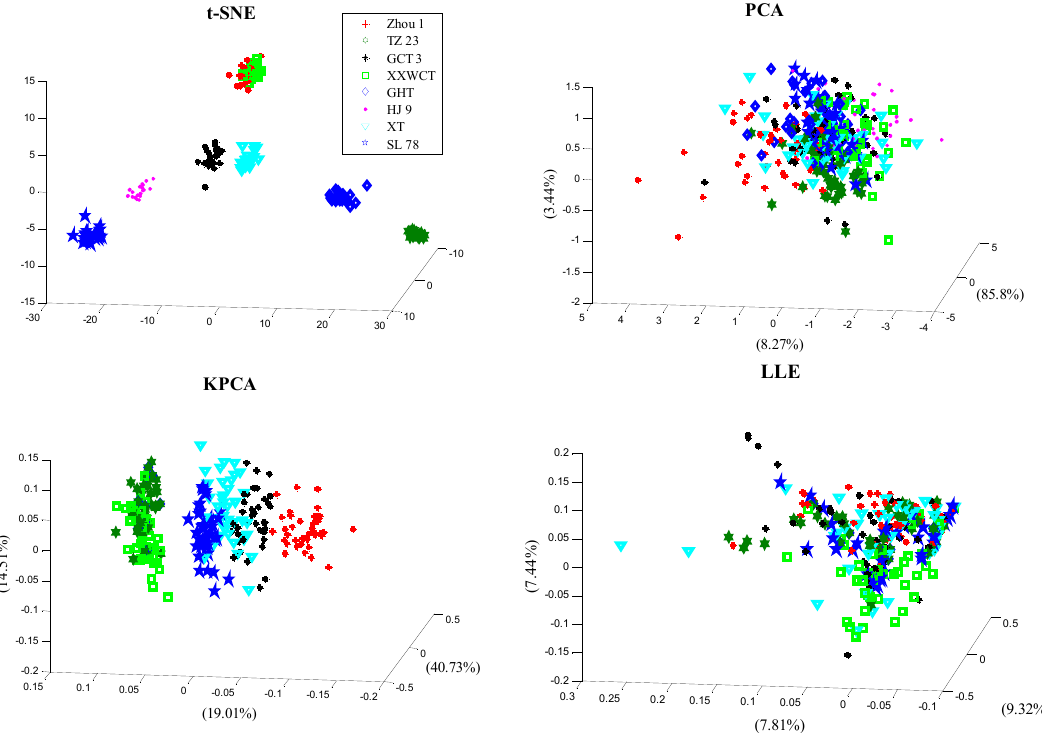
Figure 8. Scores scatter plots of samples from eight maize varieties, using the methods of t-SNE, PCA, KPCA and LLE.